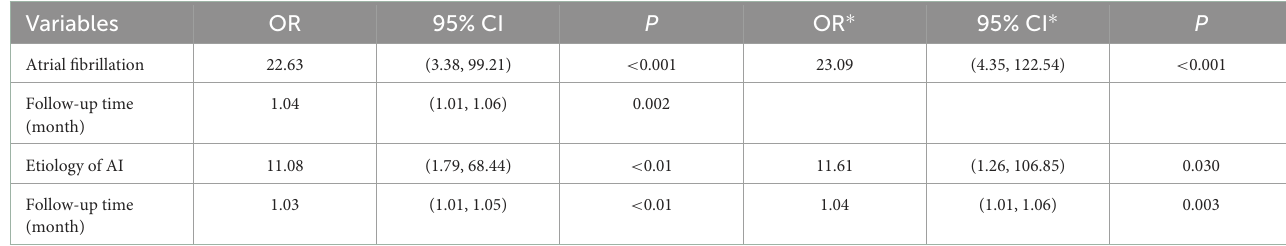
TABLE 4 Predictors for deterioration of mitral regurgitation in long-term follow-up, based on generalized linear mixed model.